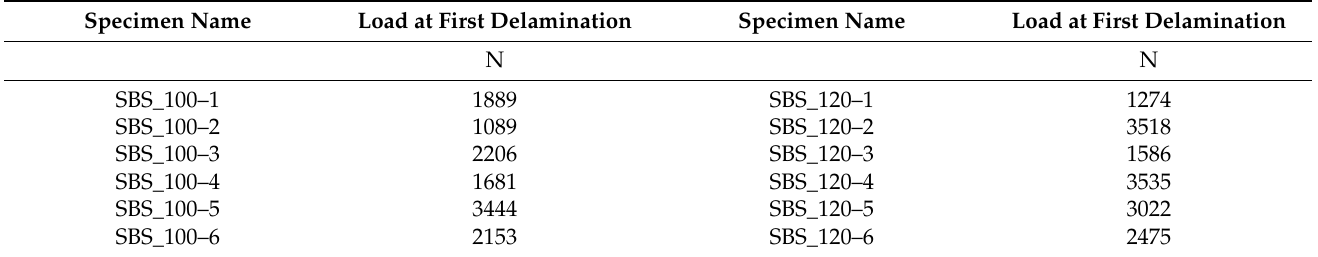
Table 3. Load at First Delamination Failure in SBS specimens based on the W.P-Freq and LZ Complexity.